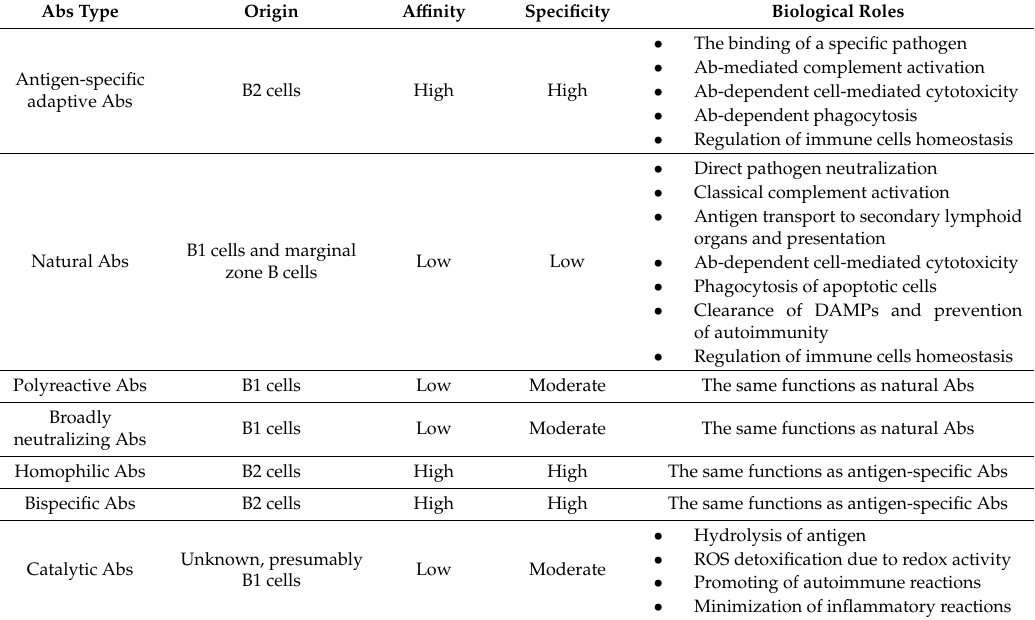
Table 2. Comparison of the origin and features of various Ab types in